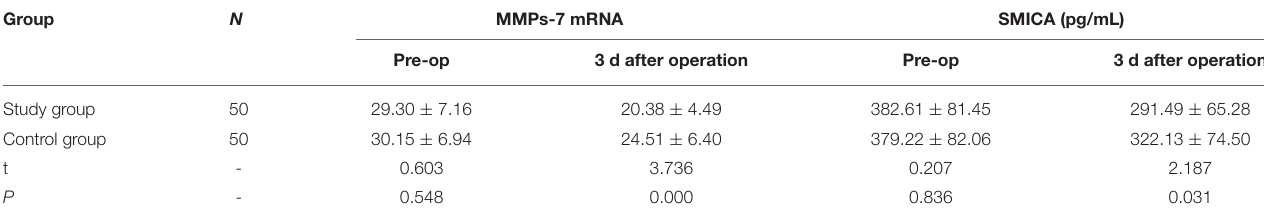
TABLE 3 | Comparison of MMPs-7 mRNA and sMICA expression levels between the two groups ( ¯ X ± s). Group